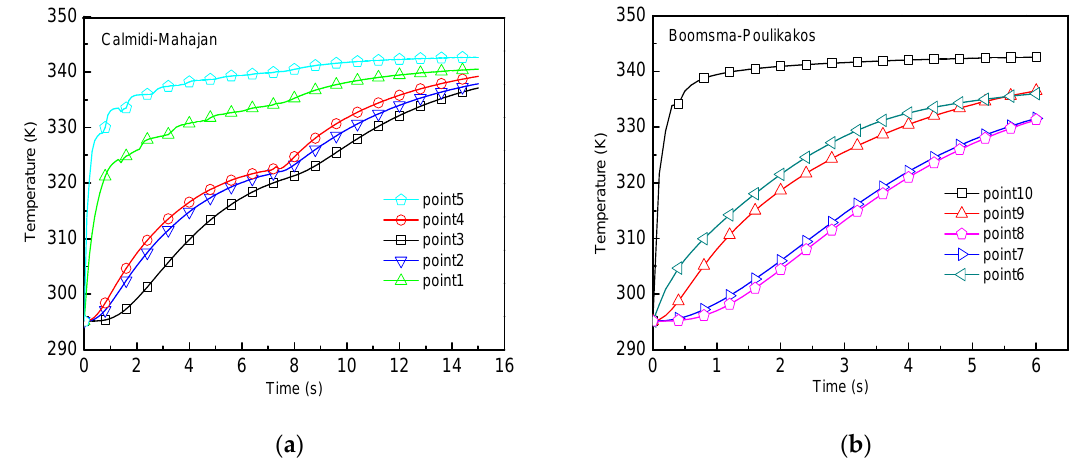
Figure 8. Temperature as a function of time during the melting process: ( a ) 2D C ‐ M model; ( b ) 3D B ‐ P model.